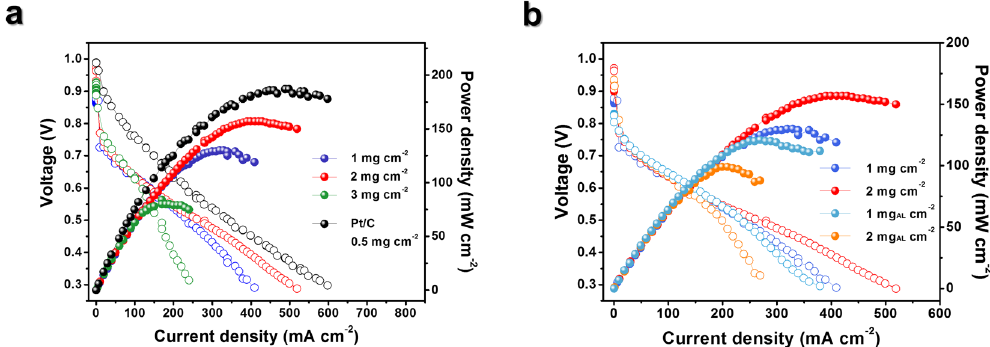
Figure 6. AEMFC performance evaluation. ( a ) I–V curves of AEMFCs containing Fe-pyPANI-K 700 °C and Pt/C cathodes. The loading of the Fe-pyPANI-K 700 °C catalyst was changed from 1 mg cm − 2 to 3 mg cm − 2 , and it was 0.5 mg cm − 2 for Pt/C ( b ) I–V curves of AEMFCs with Fe-pyPANI-K 700 °C and acid leached-Fe- pyPANI-K 700 °C cathodes with loadings of 1 mg cm − 2 and 2 mg cm − 2